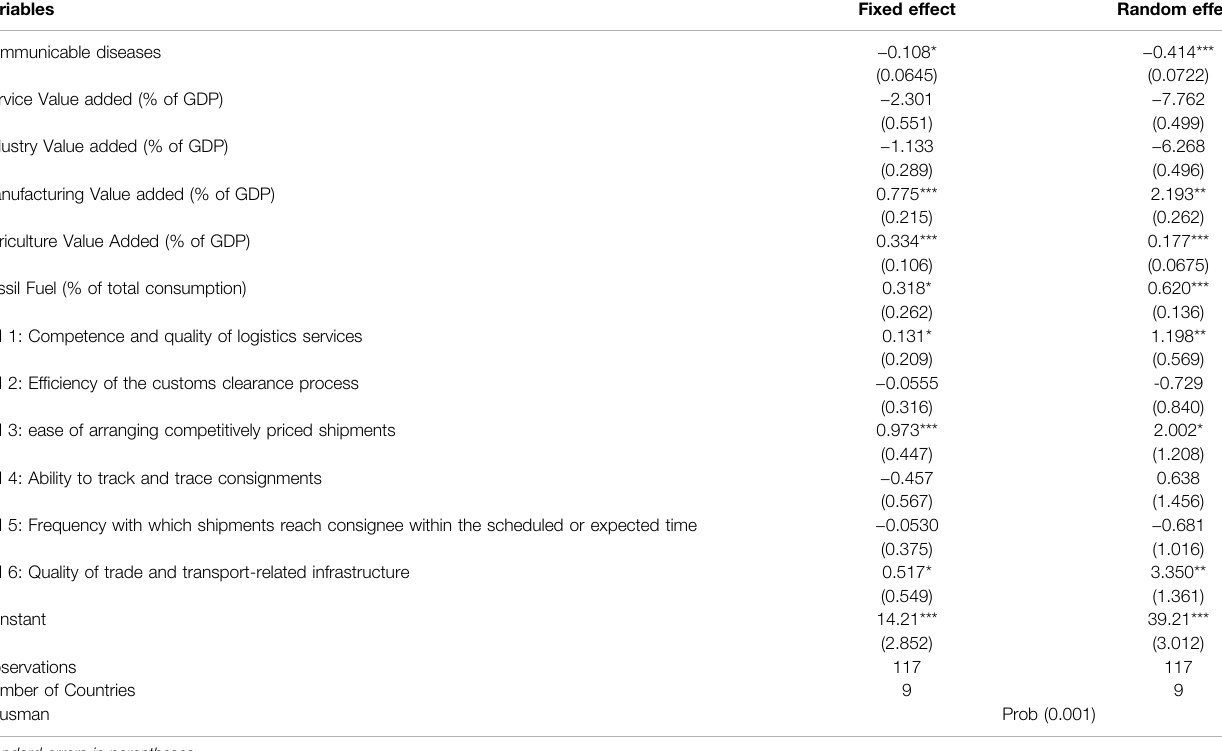
TABLE 4 | Regression analysis.